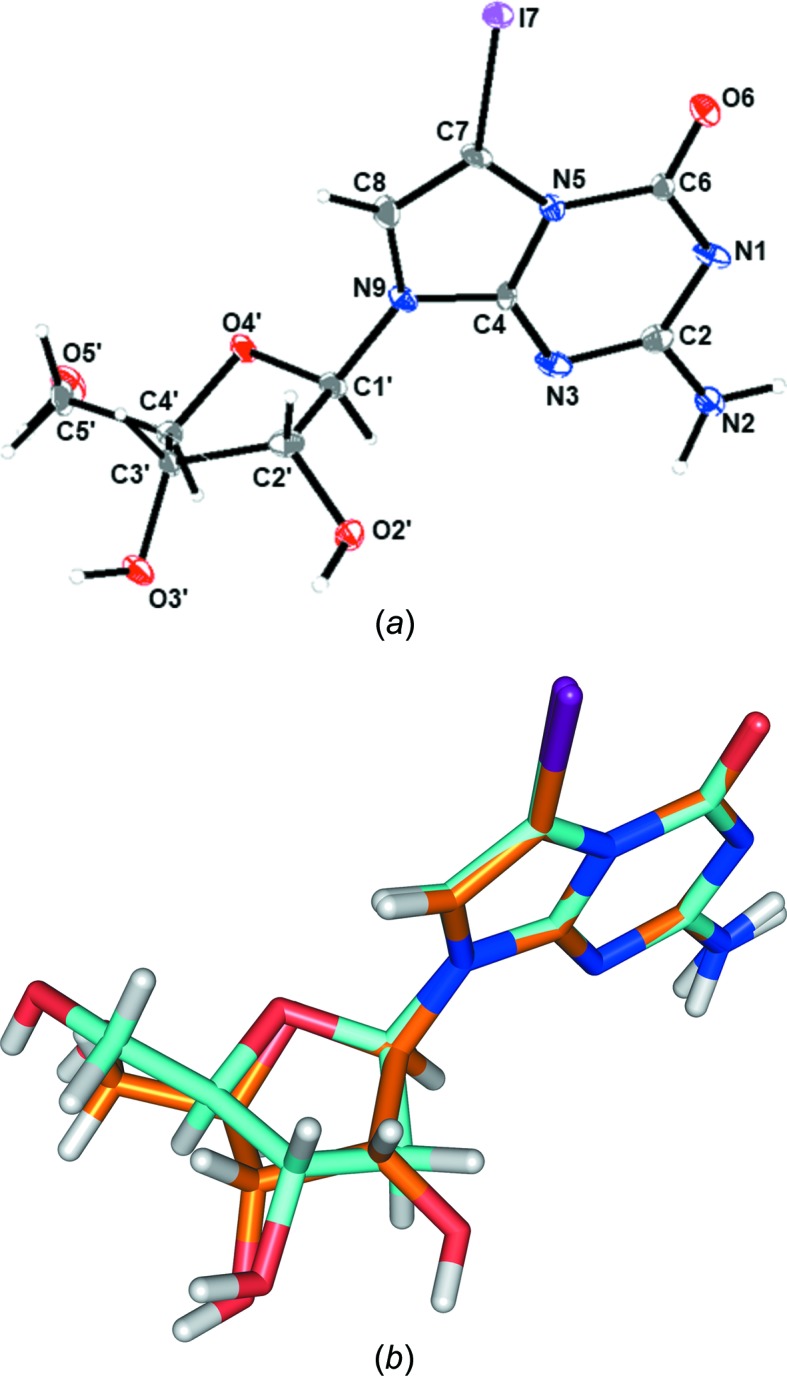
(a) Perspective view of 1, showing the atom-numbering scheme. Displacement ellipsoids are drawn at the 50% probability level and H atoms are shown as small spheres of arbitrary size. (b) Overlay of ribonucleoside 1 and the related 2′-de­oxy­ribonucleoside 2c.